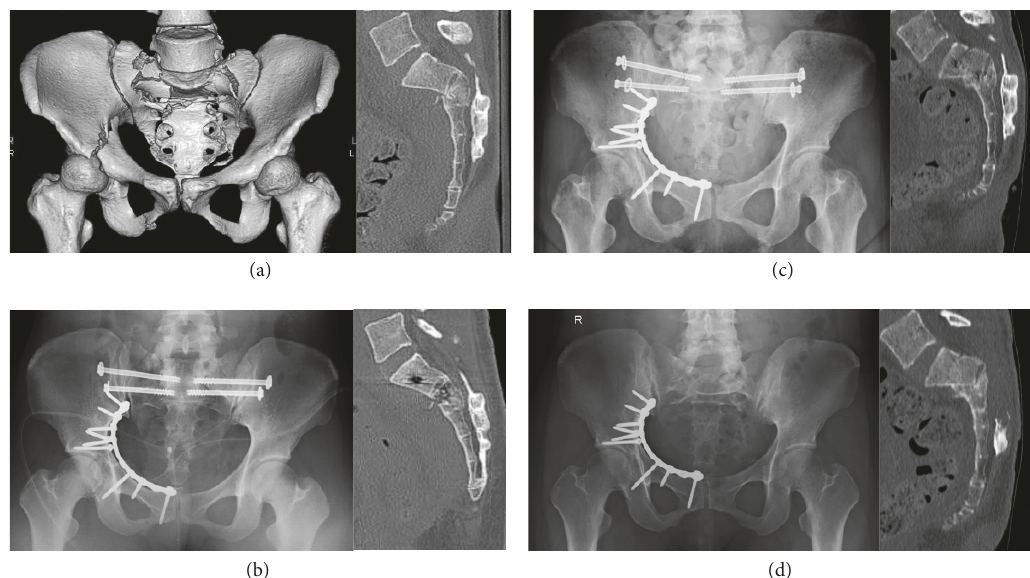
Figure 5: Case 3. This case had the greatest loss of reduction. A 25-year-old woman who was injured from a fall from a height underwent unilateral S1 and S2 bilateral iliosacral partial threaded screw fixation for a Roy-Camille type 2 H-shaped transverse sacral fracture. (a) Preoperative 3-dimensional and sagittal plane CT reconstruction of the pelvis is shown (preoperative sacral kyphotic angle: 63 ∘ ; fracture translation: 11 mm). (b) Postoperative anteroposterior radiograph and CT scan of the sacrum in the sagittal plane is shown (postoperative sacral kyphotic angle: 28 ∘ ; fracture translation: 6 mm). (c) The anteroposterior radiograph and CT scan of the sacrum in the sagittal plane taken one month after the initial operative treatment is shown (sacral kyphotic angle: 60 ∘ ; fracture translation: 14 mm). IS screw loosening was observed. Secondary sacral decompression was performed. (d) Final follow-up anteroposterior radiograph and CT scan of the sacrum in the sagittal plane is shown. Bone healing was achieved, but reduction loss and bladder/bowel dysfunction